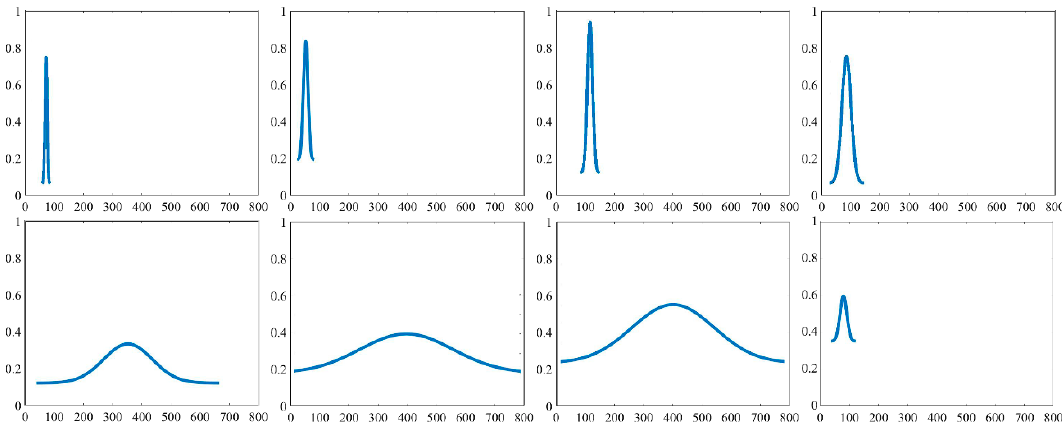
Figure 4. Example Gaussian-type templates.